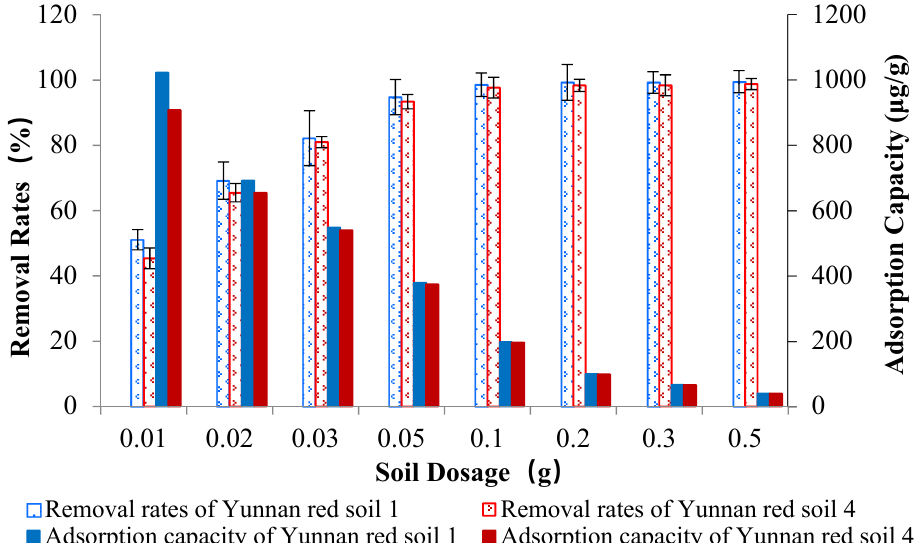
Figure 2. Removal Percentage of As(V) at Different Soil/solution Ratios.